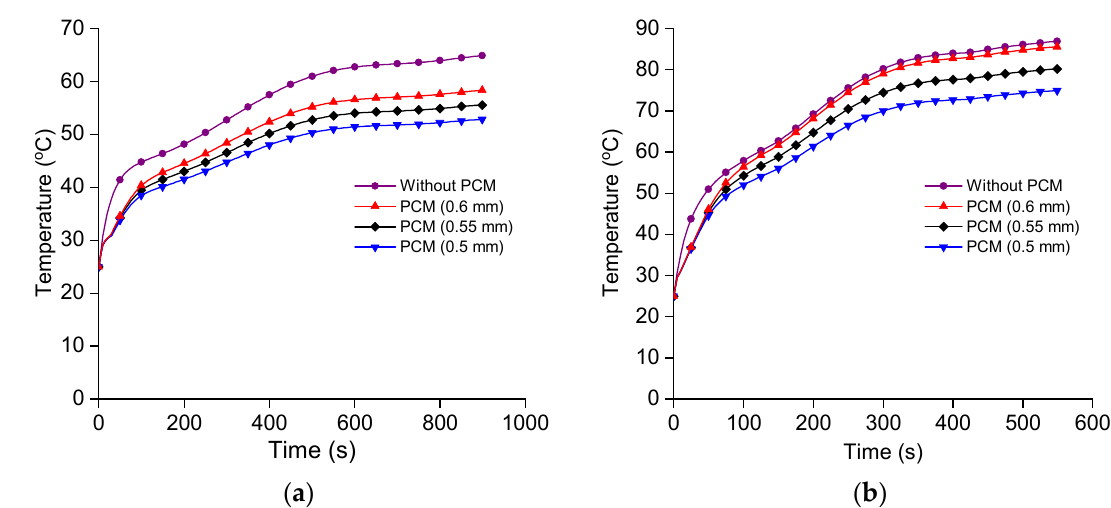
Figure 8. Battery temperatures for different PCM thicknesses at: ( a ) 3C discharge rate; ( b ) 5C discharge rate.